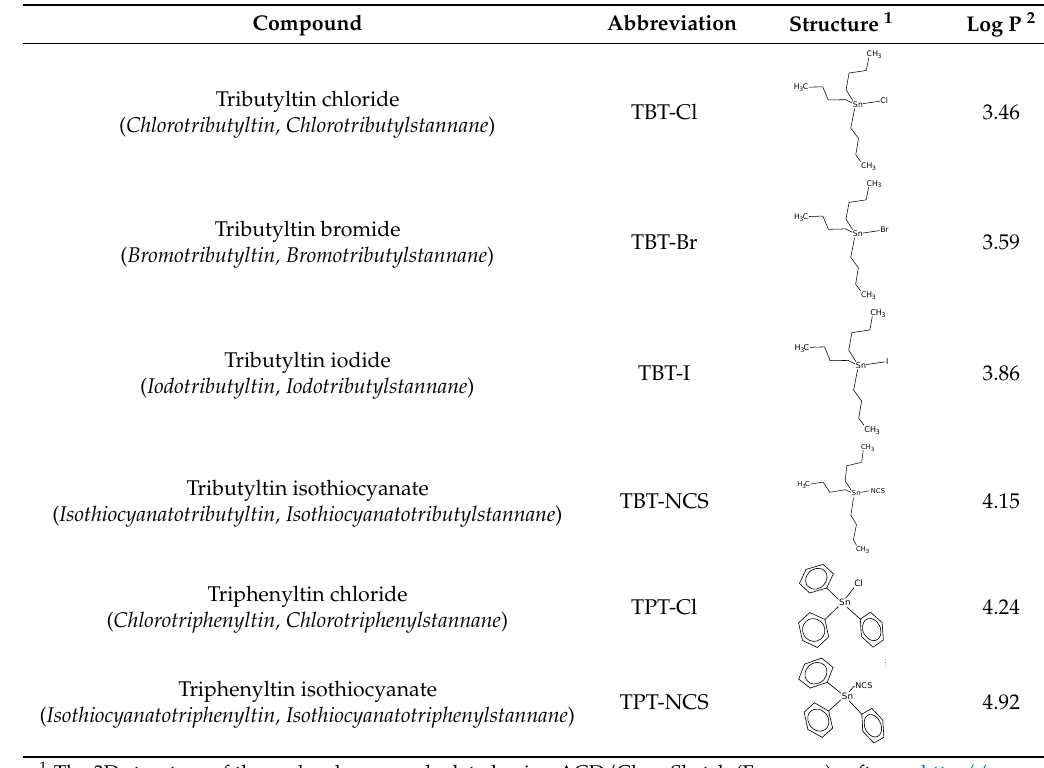
Table 1. Structures and lipophilicity of triorganotin derivatives.